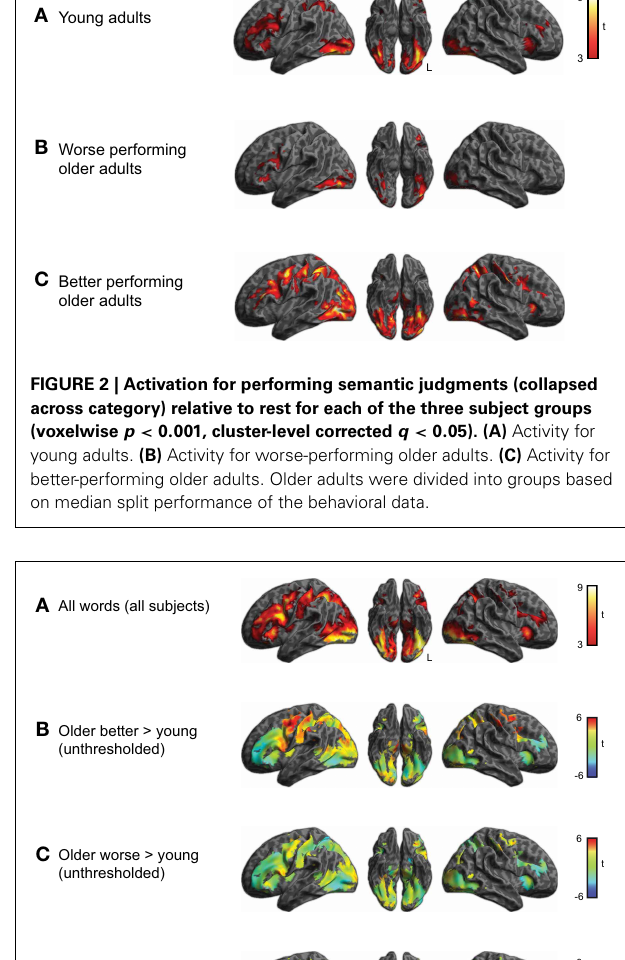
Table 1 | Maxima for fMRI activity related to semantic processing task for all